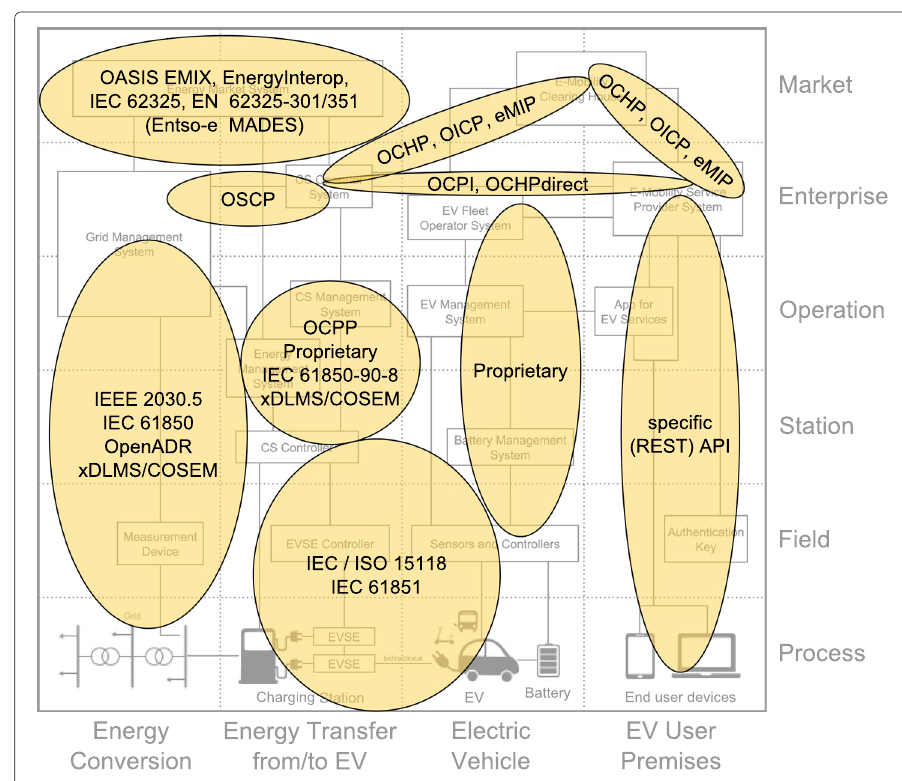
Fig. 7 EMSA information layer with standards. Compiled from ElaadNL (2017); Rodríguez et al. (2015); Schmutzler et al. (2013)